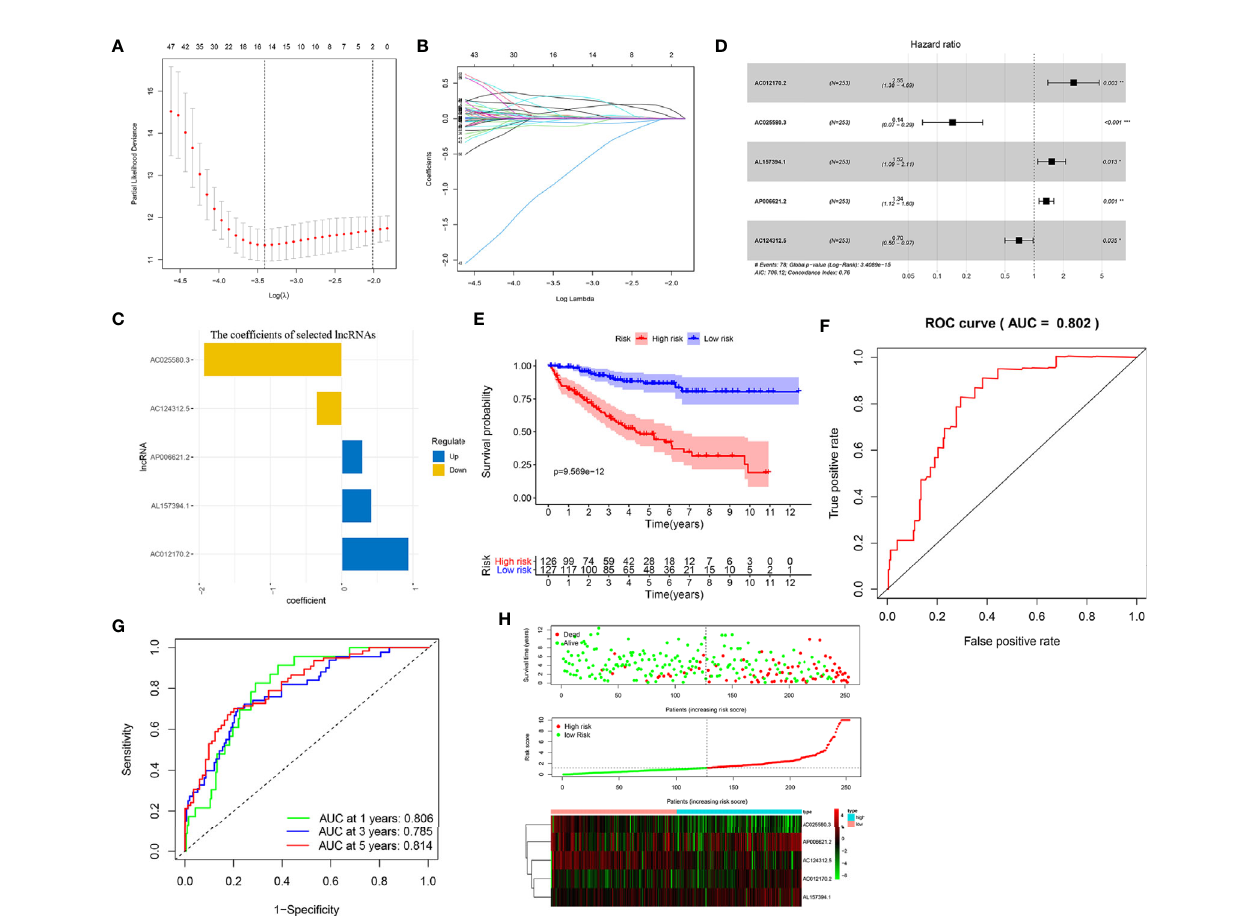
FIGURE 1 | Construction and evaluation of an m6A-related lncRNAs prognostic signature in Training set. (A – C) The least absolute shrinkage and selection operator (LASSO) Cox regression analysis was performed to avoid over fi tting in training set after univariate Cox regression analysis. Lasso coef fi cient values and vertical dashed lines were calculated at the best log (lambda) value (A, B) and Lasso coef fi cient pro fi les of the prognostic-related lncRNAs were displayed (C) . (D) Forest plot of multivariate cox regression analysis for fi ve prognostic-related lncRNAs. The Hazard Ratio (HR) value and its 95% con fi dence interval, as well as associated p-value, were showed. These HRs greater than 1 were risk factors, which indicated that high expression of these lncRNAs was unfavorable for prognosis, while HRs less than 1 were protective factors, which indicated that high expression of lncRNAs was favorable for prognosis. (E) Kaplan-Meier curves showed that the high-risk group had worse survival probability than the low-risk group in the training set. (F) Receiver operating characteristic (ROC) curves for the signature and its AUC value in training set. (G) ROC curves and their AUC value represented 1-, 3-, and 5-year predictions in training set. (H) Scatter plot showed the correlation between the survival status and risk score of KIRC patients; Risk score distribution plot showed the distribution of high-risk and low-risk KIRC patients; Heatmap of the fi ve m6A- related lncRNA expression pro fi les showed the expression of risk lncRNAs in high-risk and low-risk group in training set. *p < 0.05; **p < 0.01; ***p <